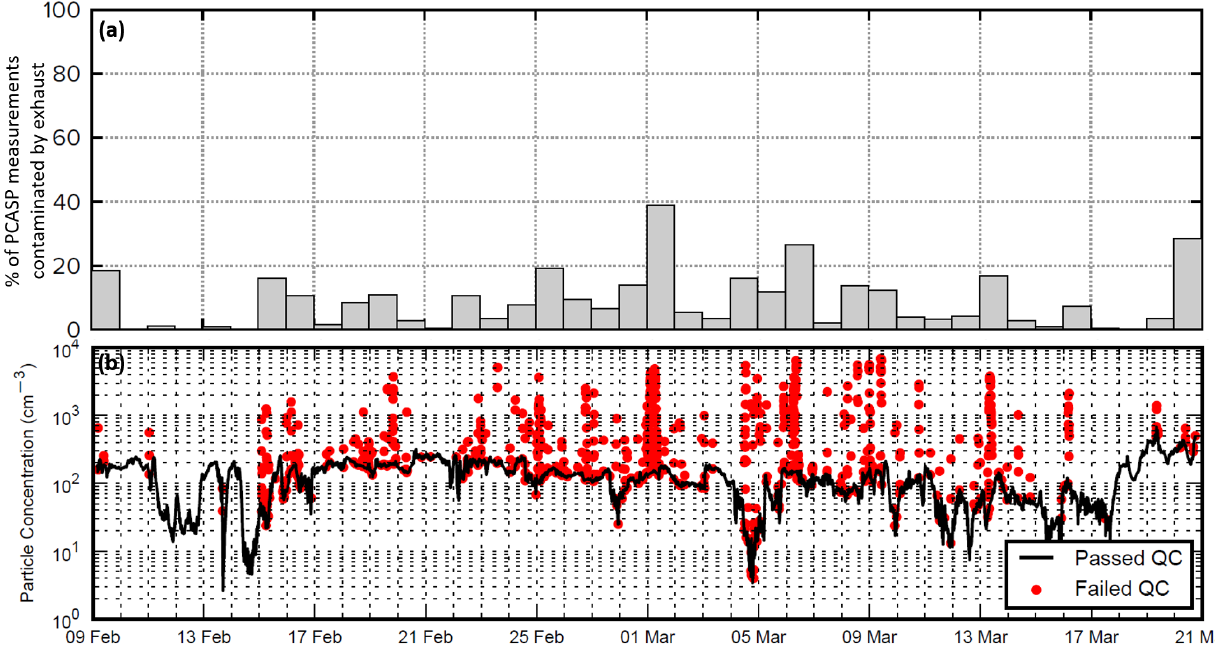
Figure 15. (a) Percentage of PCASP measurements that were contaminated by ship exhaust. (b) Comparison of raw (red) particle concen- tration and quality-controlled (black) data after a quality procedure to remove potentially contaminated aerosol samples was implemented based on wind direction, the coincident CO 2 time series, and Poisson counting statistics. This procedure is described in detail in Sect. 3.8.1.